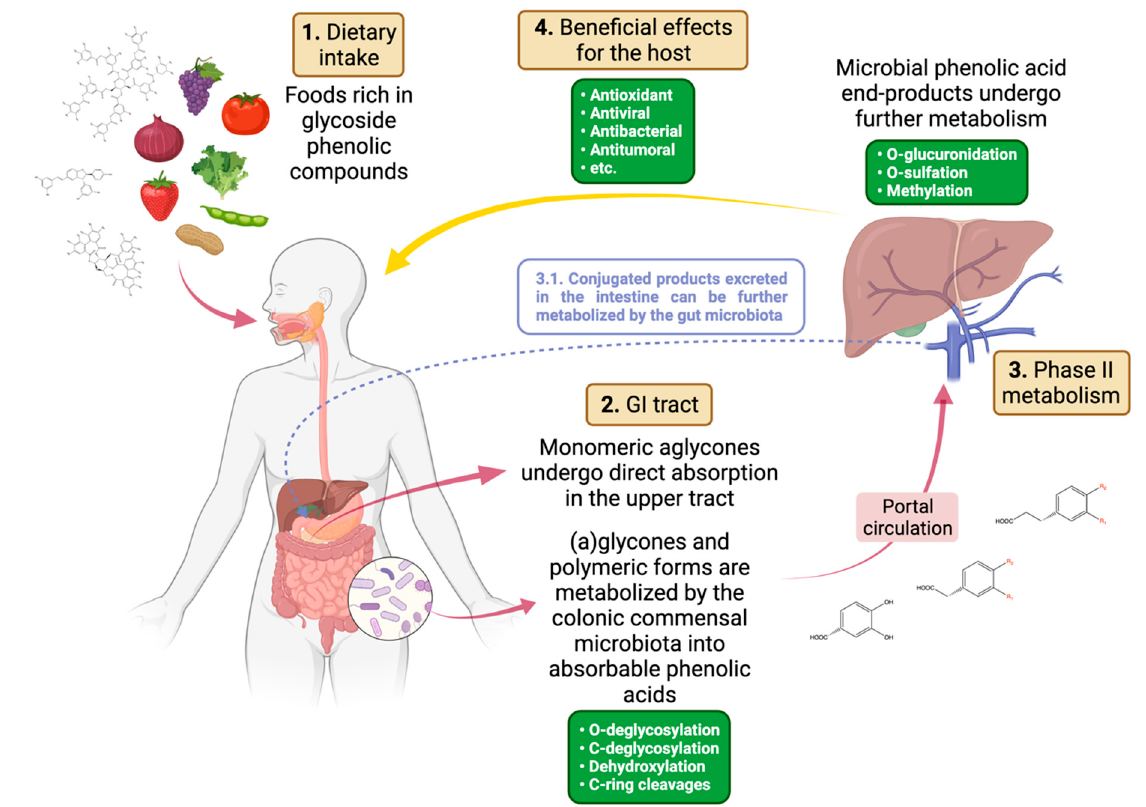
Figure 1. Schematic representation of the journey of phenolic compounds through the human body. Phenolic compounds (i.e., polyphenols and tannins) ingested with food during our daily dietary consumption mostly consist of glycosides or polymerized higher molecular weight moieties, but also include monomeric forms. In the oral cavity and upper digestive tract, a small fraction of such compounds is metabolized by the resident microbiota, releasing small amounts of saccharides and aglycones. Whether the monomeric aglycones come from this first step of degradation or directly from ingested food, they undergo absorption through the intestinal epithelium. Most of the phenolic moieties—the fraction of which depends on their structure as well as the food matrix they were embedded into—reach the colon unchanged and come into contact with the trillions of commensal microorganisms. Here, deglycosylation reactions release saccharides from the sugar moieties, then dehydroxylation and phenolic ring-targeted metabolism break down the complex phenolic structures into simple and absorbable phenolic acids, among which protocatechuic acid, 3-(3,4-dihydroxyphenyl) acetic acid and 3-(3,4-dihydroxyphenyl) propionic acid. Such metabolic processes provide support for microbial growth, contributing to the production of complex microbial metabolites, still largely unknown. The phenolic end-products are absorbed through the epithelium and—as for the simple monomeric aglycones absorbed in the upper intestine—reach the liver via the portal circulation, where they undergo phase II metabolism reactions such as glucuronidation, sulfation and methylation. The resulting glucuronate, sulfate and methyl compounds are found in the bloodstream and are most likely responsible for the beneficial effects reported, including antitumoral, antioxidant, antibacterial and antiviral effects. Eventually, they can still be metabolized by the gut microbiota after intestinal excretion of the conjugated products. GI, gastrointestinal. Image created in BioRender.com. Figure S2: Chemical structure of stilbenes, phenolic acids and gut microbiota-derived phenolic me- tabolites; Figure S3: Chemical structure of tannins; Table S1: Summarized information of cited in vitro and in vivo studies.